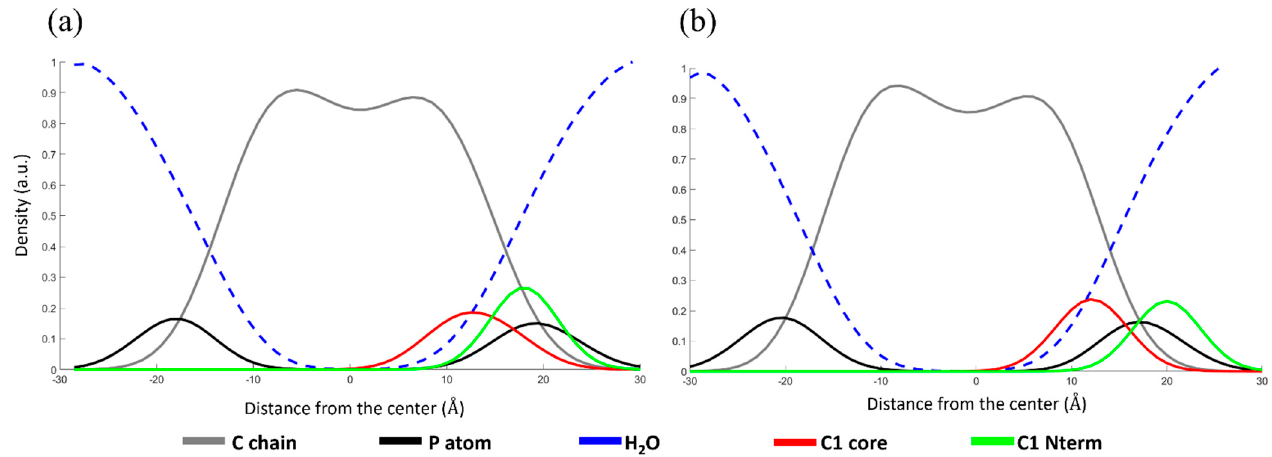
Figure 5. Density profile ( a ) at pH = 5.0, ( b ) at pH = 7.0. The chains and the heads of POPC are shown in gray and black lines, respectively. Dashed blue line represent water molecules. C1 aromatic core and the C1 N terminal are shown in red and green, respectively.